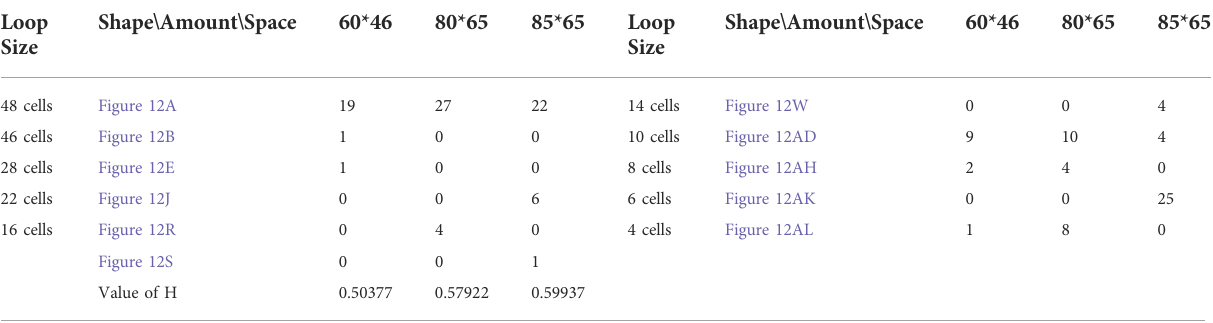
TABLE 14 Statistical numbers of the loops with various structures for the greedy selection mechanism on different cellular spaces starting from the initial con fi guration in Figure 7E. Loop Shape ∖ Amount ∖ Space Size